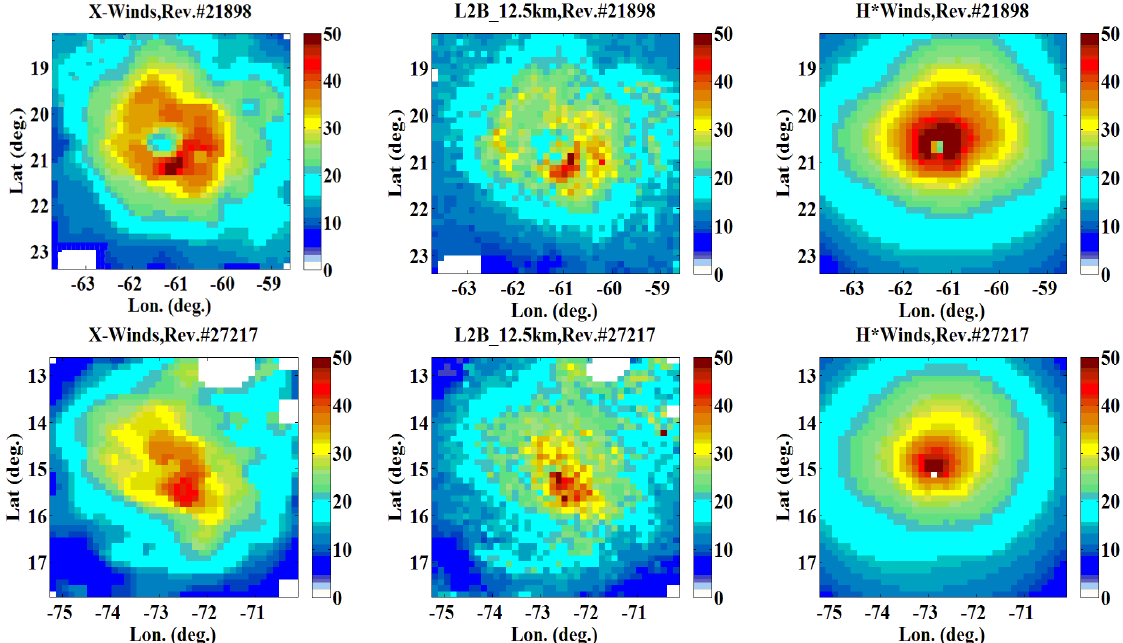
Figure 7. Surface wind speeds for Hurricane Fabian (upper panels) and Hurricane Ivan (lower panels). Color indicates wind speeds from 0–50 m/s. Left panels are X-Winds retrievals, center panels are JPL L2B-12.5 km, and right panels are H*Wind surface